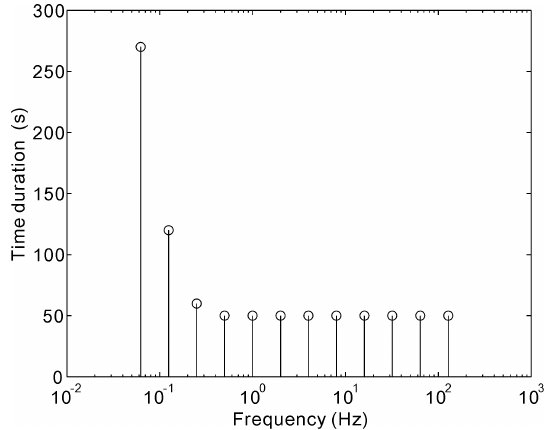
Figure 3. Stack time length for a typical SIP frequency stepping schedule.